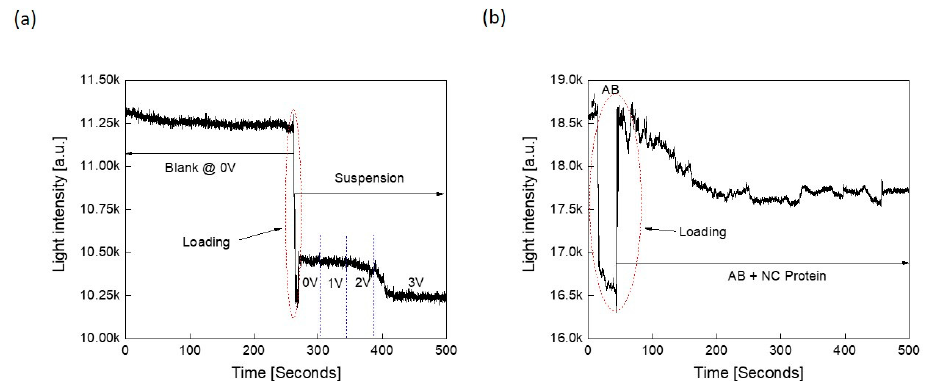
Figure 8. Opto-electrical measurements: ( a ) Measured NC protein optical response versus time at different DC bias voltages. ( b ) Binding measurements between NC protein and its corresponding antibody after subjected the solution to an electric field.